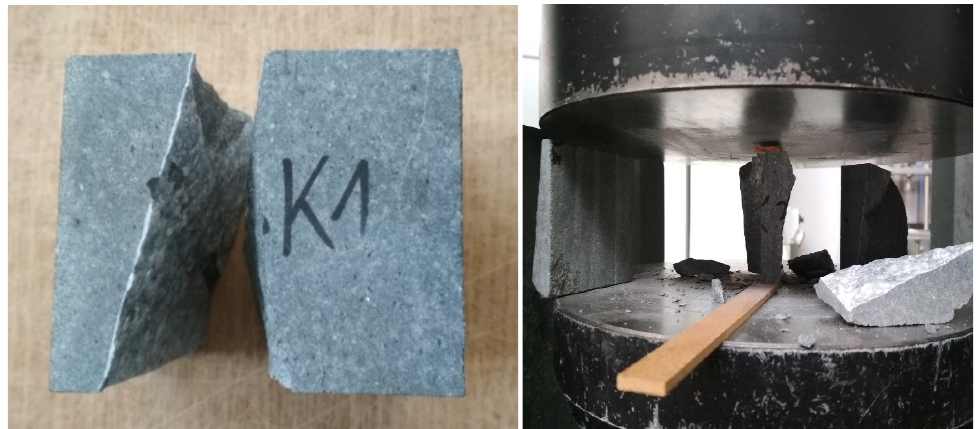
Figure 8: The quasi-Brazilian test.